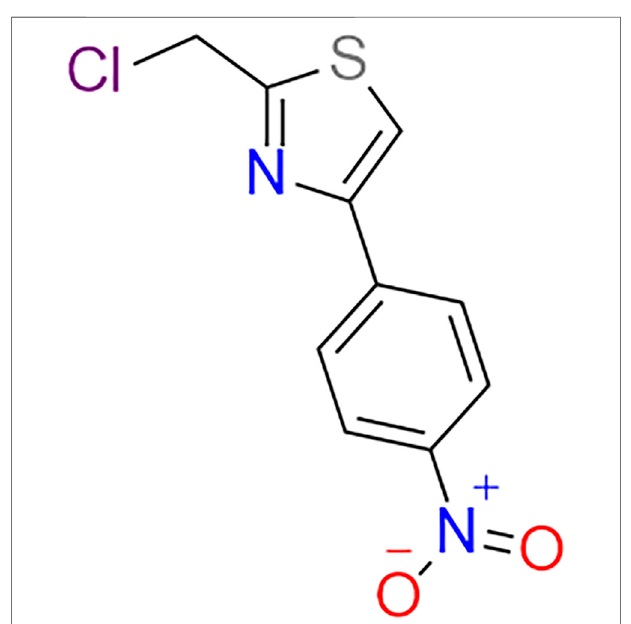
FIGURE 2 | The chemical construction of